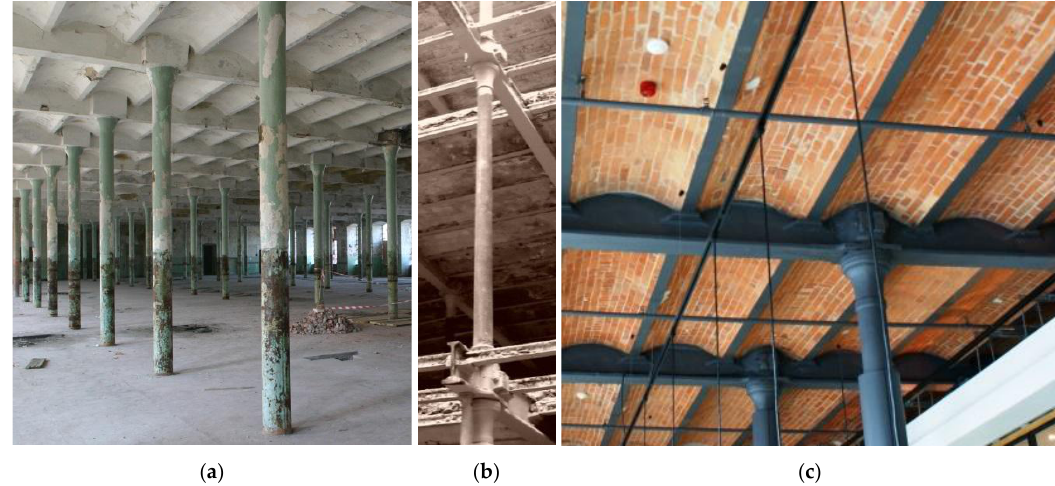
Figure 4. Structure of the former I. Poznański’s spinning mill: ( a ) before, ( b ) during, and ( c ) after reconstruction.